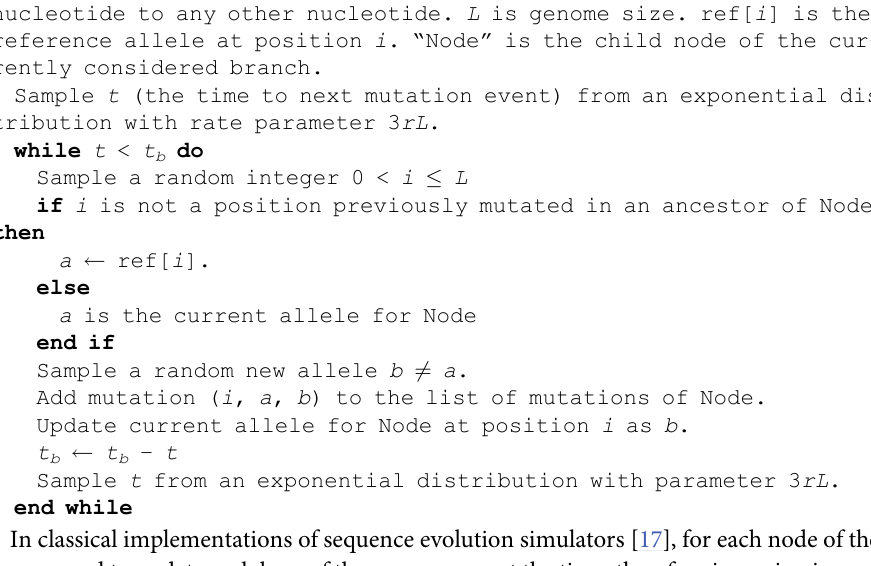
Algorithm 1 Simple algorithm for one phylogenetic